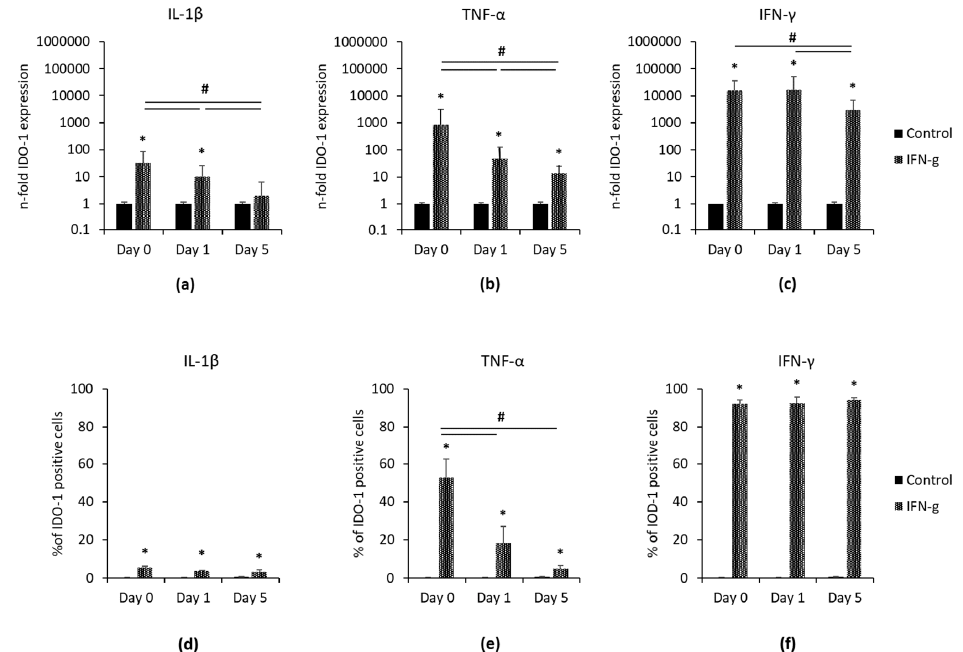
Figure 2. Continuing e ff ect of IL-1 β , TNF- α or IFN- γ on IDO-1 expression in hPDLSCs. Primary hPDLSCs were stimulated with 5 ng / mL IL-1 β ( a , d ), 10 ng / mL TNF- α ( b , e ) or 100 ng / mL IFN- γ ( c , f ). After 48 h of incubation, the medium was changed to DMEM without any inflammatory stimuli. Gene expression levels ( a – c ) and the percentage of IDO-1 positive hPDLSCs ( d – f ) were determined by qPCR and intracellular immunostaining followed by flow cytometry analysis, immediately and one and five days after removing inflammatory stimuli. ( a – c ) The y-axis shows the n-fold IDO-1 gene expression compared to the appropriate unstimulated control (n-fold IDO-1 expression = 1) in a logarithmic scale, as calculated by the 2- ∆∆ Ct method. ( d – f ) The y-axis shows the percentage of IDO-1 positive hPDLSCs in a linear scale. All data are presented as mean values (± S.E.M.) obtained from five ( a – c ) and six ( d – f ) independent experiments using hPDLSCs isolated from five or six different individuals, respectively. * p -value ≤ 0.05, significantly increased compared to unstimulated control; # p -value ≤ 0.05, significantly different between groups as indicated .